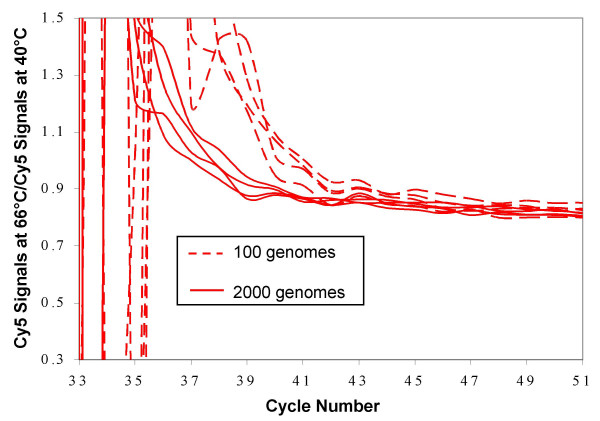
Fluorescence ratios generated by Two-Temperature LATE-PCR genotyping are independent of starting genome copy number. This figure shows a plot of the ratio of Cy5 readings at 50°C and 25°C derived from a LATE-PCR amplification of the genomic DNA segment containing the rs858521 [C/G] SNP monitored with a ResonSense® probe against the rs858521 C allele. Red lines, homozygous CC replicates containing 2000 starting genomes; red dotted lines, homozygous CC replicates containing 100 starting genomes. Both sets of replicate homozygous samples generate the same two-temperature fluorescence ratio even though these samples differ in their amount of starting material.